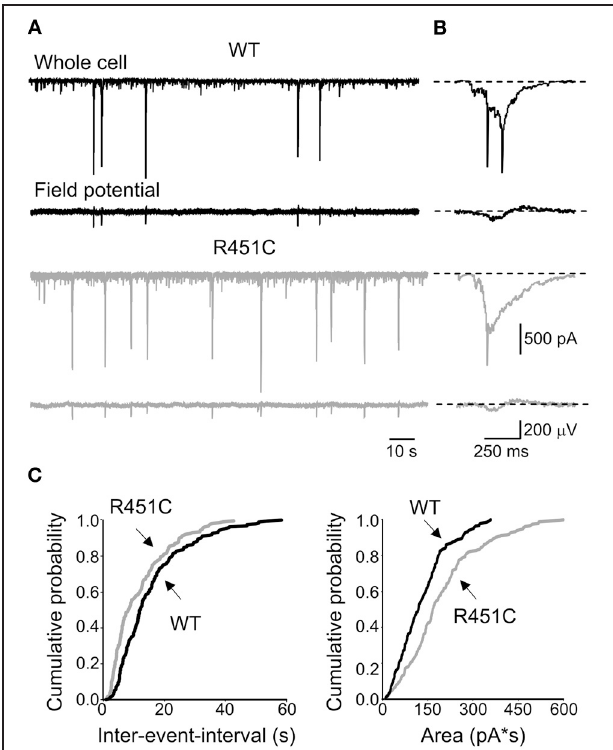
FIGURE 1 | The NL3 R451C knock-in mutation enhances correlated network activity in the immature hippocampus. (A) Whole cell voltage-clamp (upper traces) and extracellular field recordings (lower traces) of GDPs recorded at P5 in hippocampal slices obtained from WT (black) and NL3 R451C mice (gray). (B) GDPs from the traces in (A) shown on an expanded time scale. (C) Cumulative probability plots of inter-event intervals and areas of inward currents underlying GDPs recorded from WT ( n = 24) and NL3 R451C mice ( n = 17) between P4 and P9. Curves in the plots referring to WT and R451C KI mice are significantly different ( p < 0 . 01; p < 0 . 01; K–S